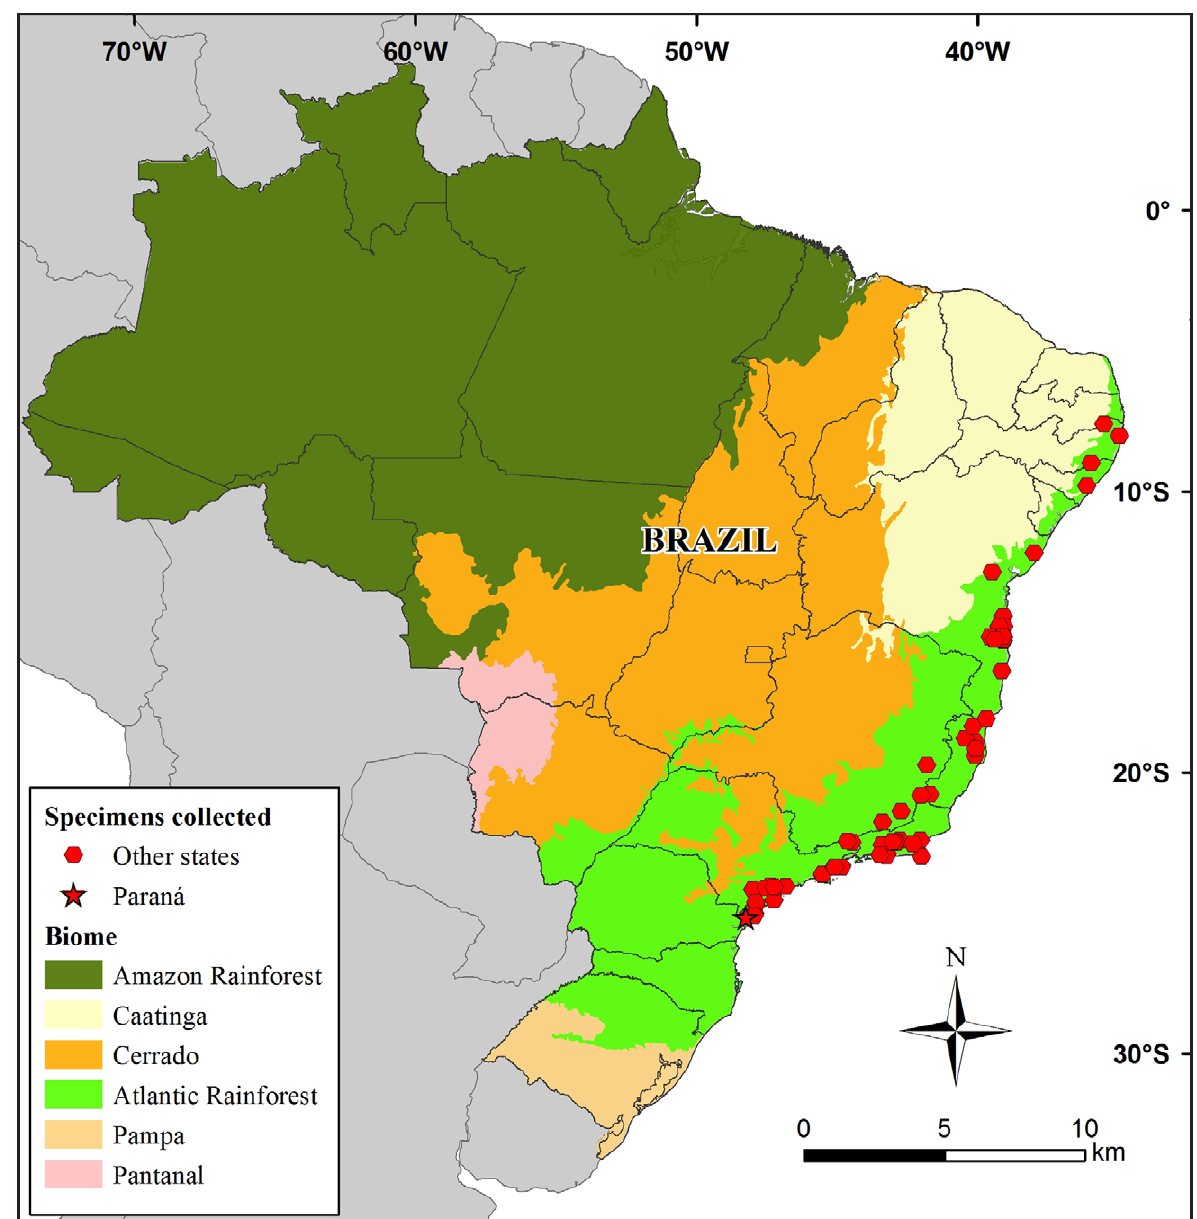
Figure 8. Distribution of Virola gardneri (A.DC.)